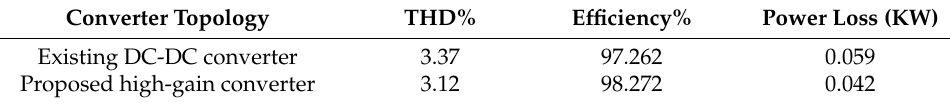
Table 4. Comparison table of the converter